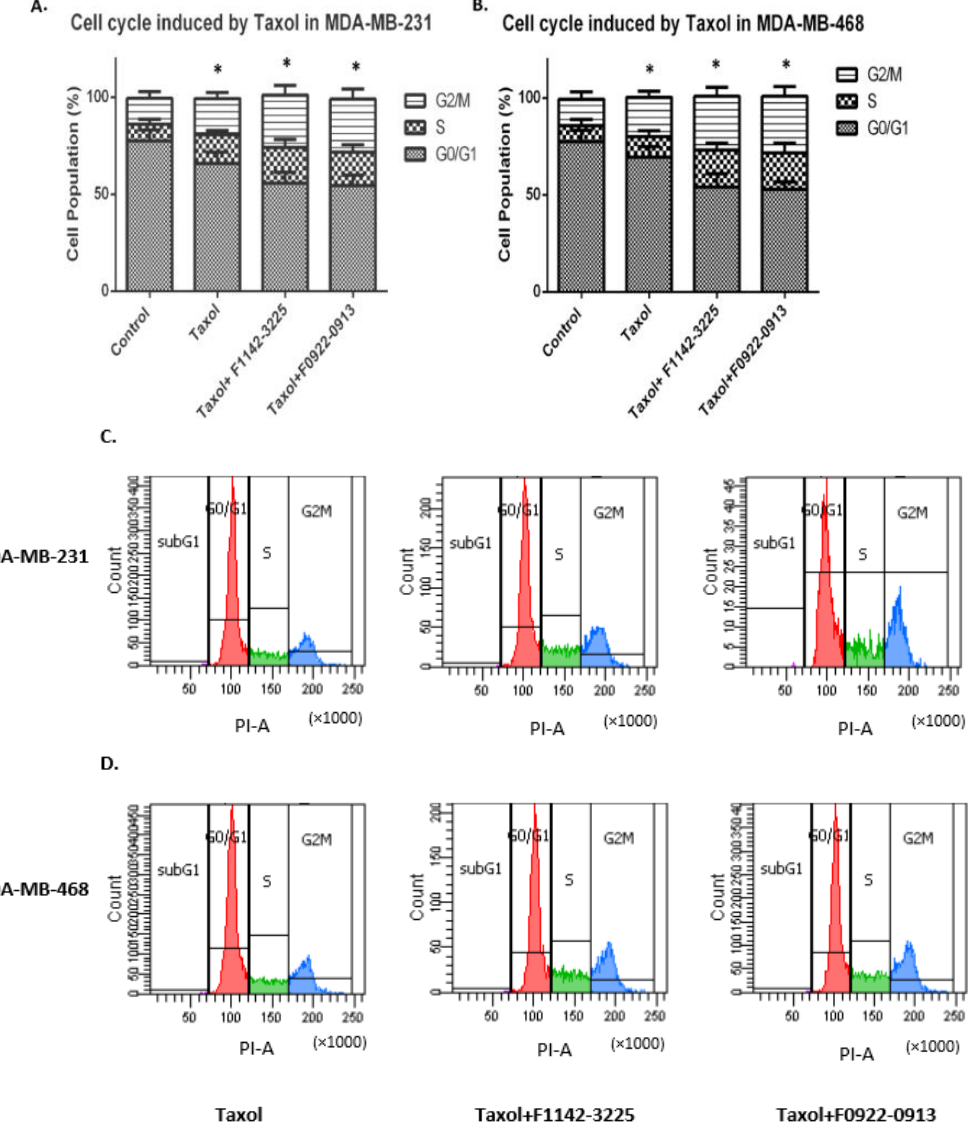
Figure 6. Cell cycle distribution in response to combined treatment of taxol and inhibitors in MDA-MB-231 and MDA-MB-468 cells. ( A , C ) Cell cycle distribution in response to combination treatment of taxol and either F1142-3225 or F0922-0913 in MDA-MB-231 cells. ( B , D ) Cell cycle distribution in response to combination treatment of taxol and either F1142-3225 or F0922-0913 in MDA-MB-468 cells. Data are presented as % of living cells (G0/G1, S, and G2/M cells = 100%). Each number represents the mean of experiments, carried out in triplicate (mean ± SD). Statistical sig-nificance was determined by one-way ANOVA; * p ˂ 0.05 vs. control (Ctrl). Flow cytometry figures depict the distribution of each phase of the cell cycle after treatment.. In contrast, in MCF10 cells, there was no significant regulation of G2/M arrest in groups of combination treatments, compared with the cells just treated with taxol (23.6% vs. 23.4%) (Figure 7A). Furthermore, following combination treatment of taxol and the interface inhibitors, CDK2 protein expression was significantly decreased to 59.9%, com- pared with the group treated with taxol alone (Figure 7B). Thus, it is suggested that the down-regulation of CDK2 in the combined treatment can arrest the TNBC cancer cell cycle and enhance the anti-proliferation effects, imposing a positive effect on the treatments for breast cancer [26–28].